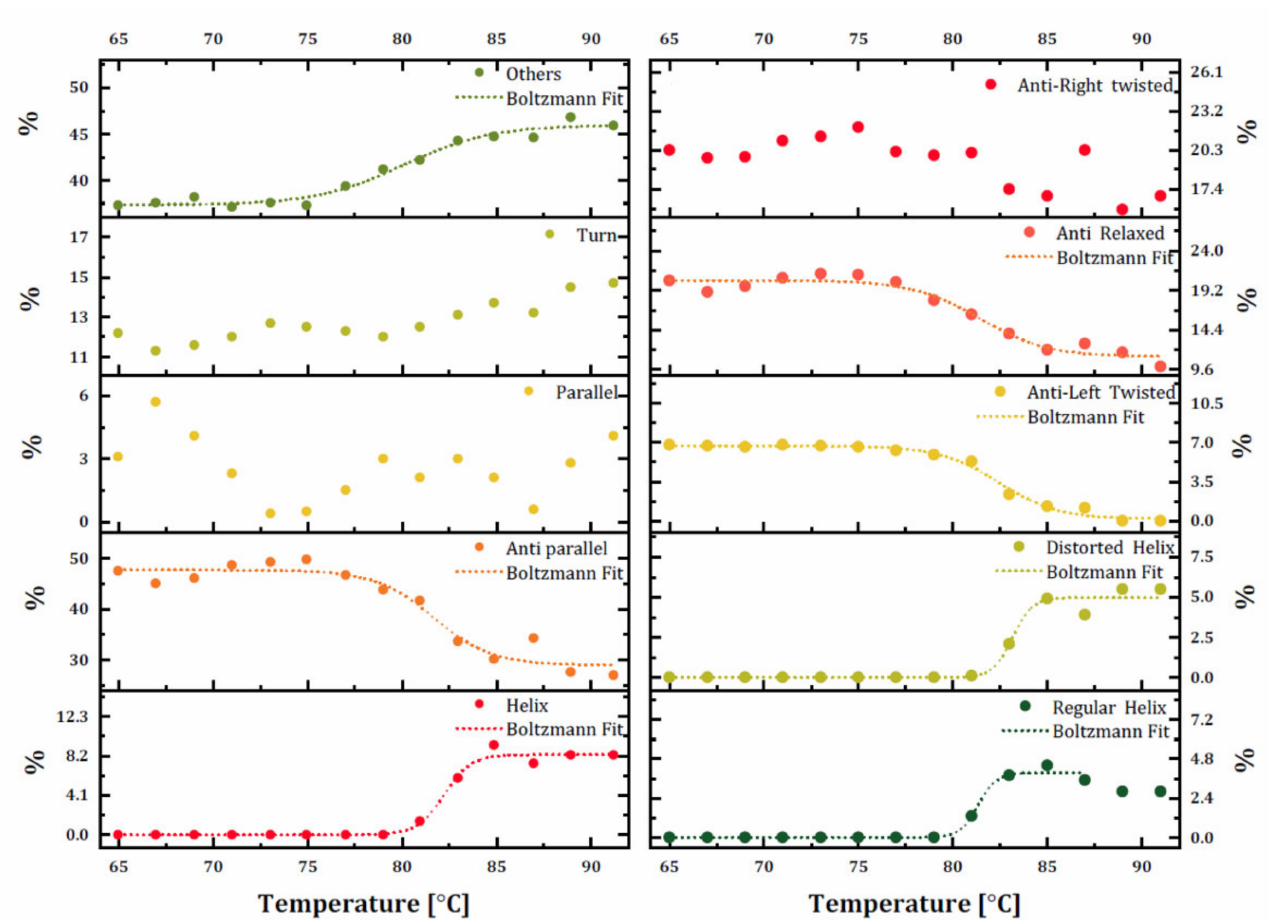
Figure 4. Estimated secondary structure subunits of trastuzumab at various temperatures. The data were collected with CD and processed with BeStSel [15] online